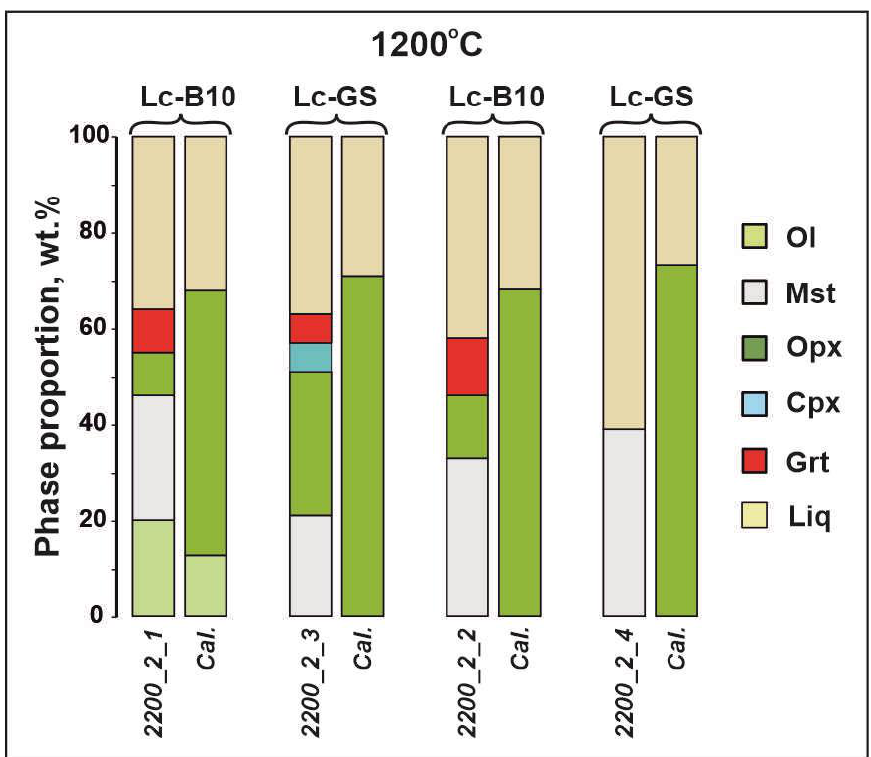
Figure 7. Plots showing the comparisons between phase proportions in the lherzolite-carbonatite B10 (Lc-B10) and lherzolite-GS (Lc-GS) systems with molecular CO 2 and H 2 O from the experiments conducted in this study at 6.3 GPa and 1200 °C (Exp.) and predicted phase proportions according to the model [21] under the same P-T conditions and at bulk compositions (Cal.).